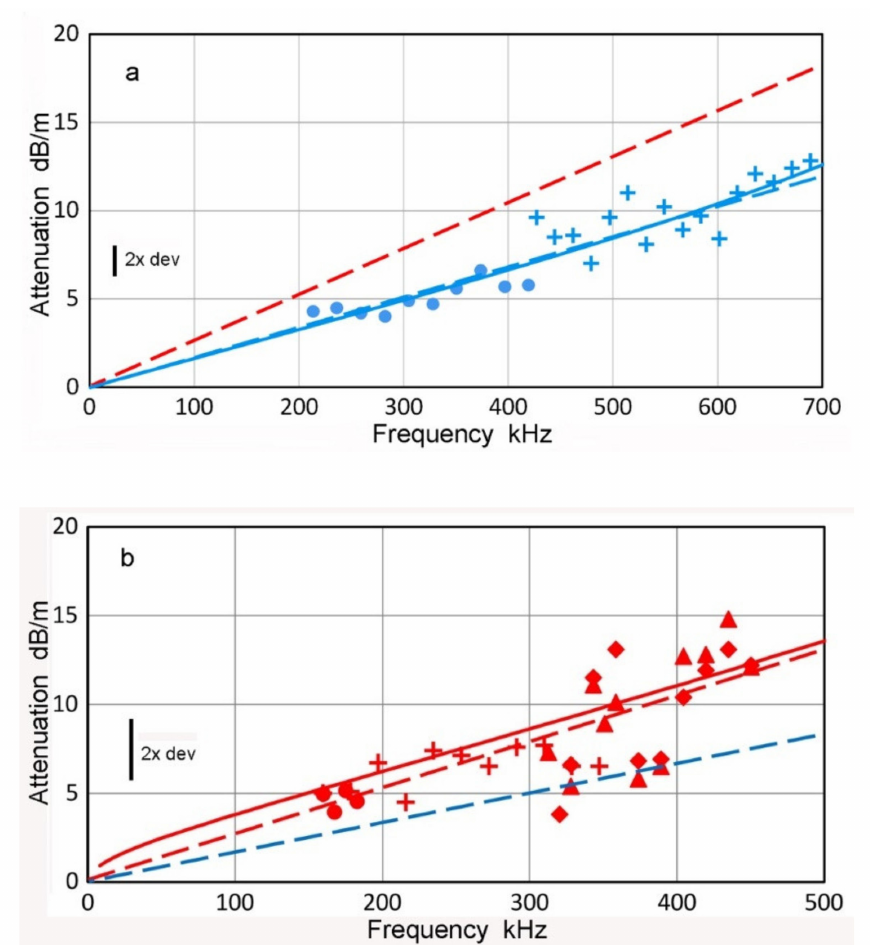
Figure 6. ( a ) α –S o values for Al-1100 sheet of 2.1-mm thickness in blue symbols. α –S o values plotted in dots used PAC Pico as Tx and + symbols KRN-BB-PCP as Tx. Both Tx’s were attached on the end face. KRN-BB-PC was Rx for both. Calculated values of α –S o are plotted in a solid blue curve. α L and α T : Blue and red dash lines. Vertical bar shows 2 × dev. ( b ) Four sets of α –A o values for Al-1100 sheet of 2.1-mm thickness are plotted in red symbols. Data with + symbols used NDT C16 Tx at 60 ◦ incident angle, dot, diamond and triangle symbols used surface-mounted KRN-BB-PCP Tx, located near edge, which allowed firm clamping and two-surface detection approach. The dot data used 200-kHz sinewave pulse, while the rest used short-pulse excitation. KRN-BB-PC was Rx for all four. Calculated α –A o (solid red curve), α L and α T (blue and red dashed lines) are plotted as in Figure 5b. Vertical bar shows 2 ×